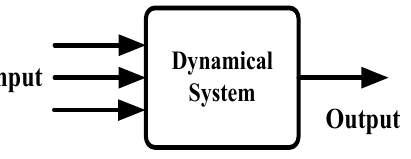
Figure 1. Illustration of the input/output block diagram of a